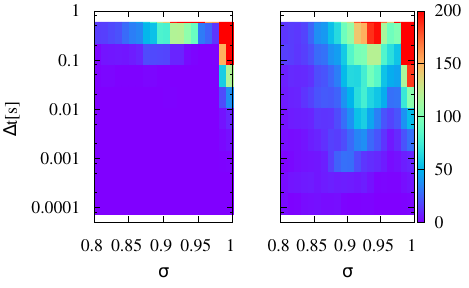
Figure 9. Distribution of 1t requirement for the conditions of the first-order derivative (Eq. 19) as a function of σ for interpolation Fig. 9. Distribution of ∆ t requirement for the condition on the first order derivative (Eq. 19) as a function of σ for interpolation algo- algorithms A (left) and D (right). rithms A (left) and D (right).